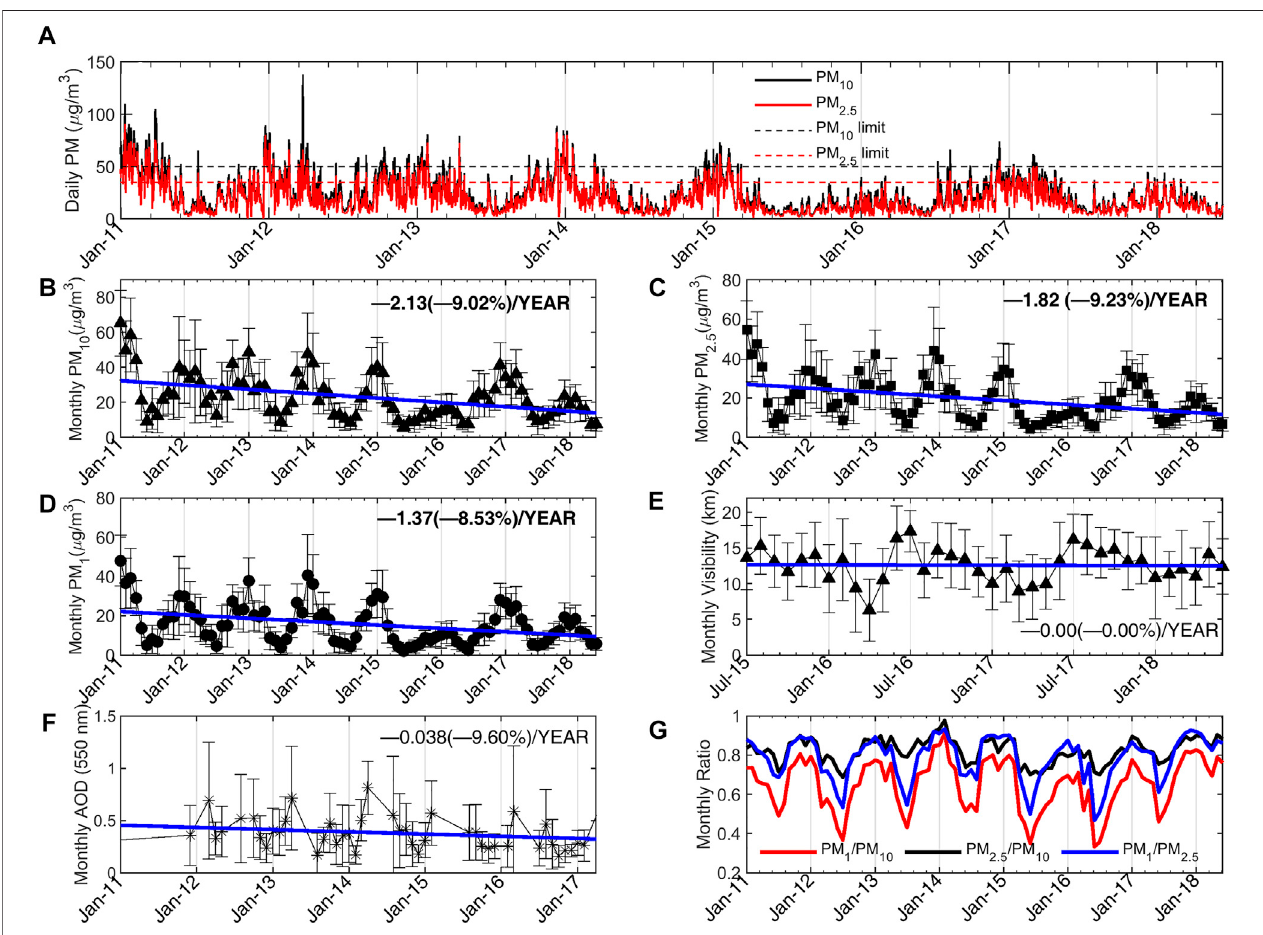
FIGURE2| TimeseriesofdailyPM 10 andPM 2.5 massconcentrationsfromJan.2011toJune2018 (A) ,variabilityofmonthlyPMconcentrations (B – D) ,visibility (E) , AOD (F) , and ratios of PM (G) at Xichong site. The statistical parameters in the fi gures are linear trends of monthly PM, visibility and AOD. Bold font indicates trends are statistically signi fi cant at the 95% con fi dence